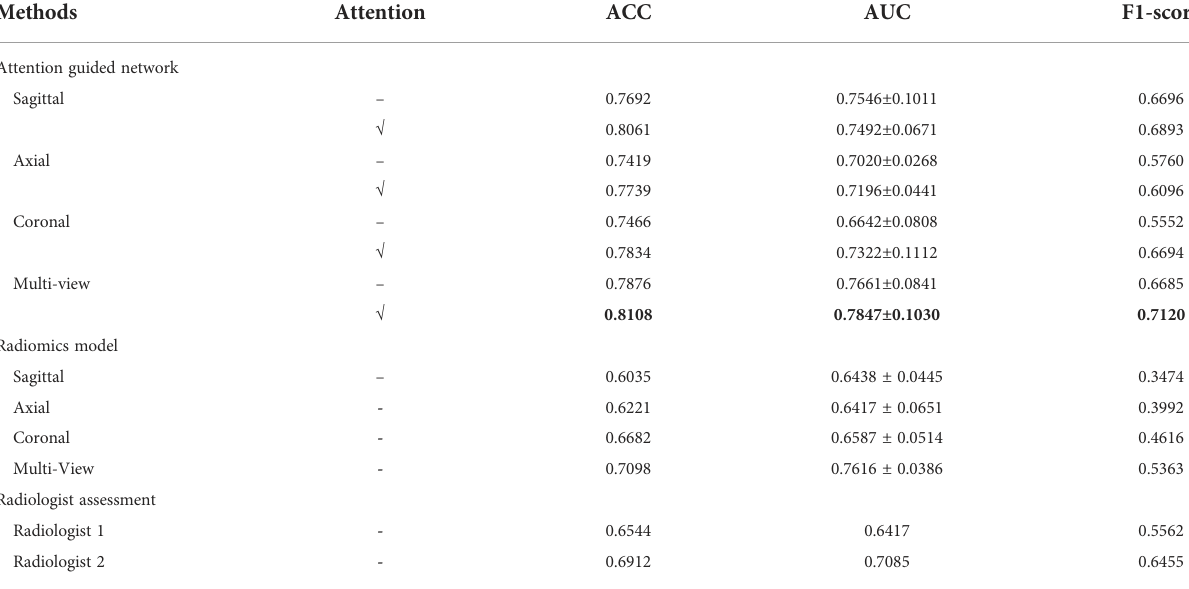
TABLE 2 The Comparison of Classi fi cation Performance among Different Methods and Con fi gurations on 5-fold Cross-validation. Methods